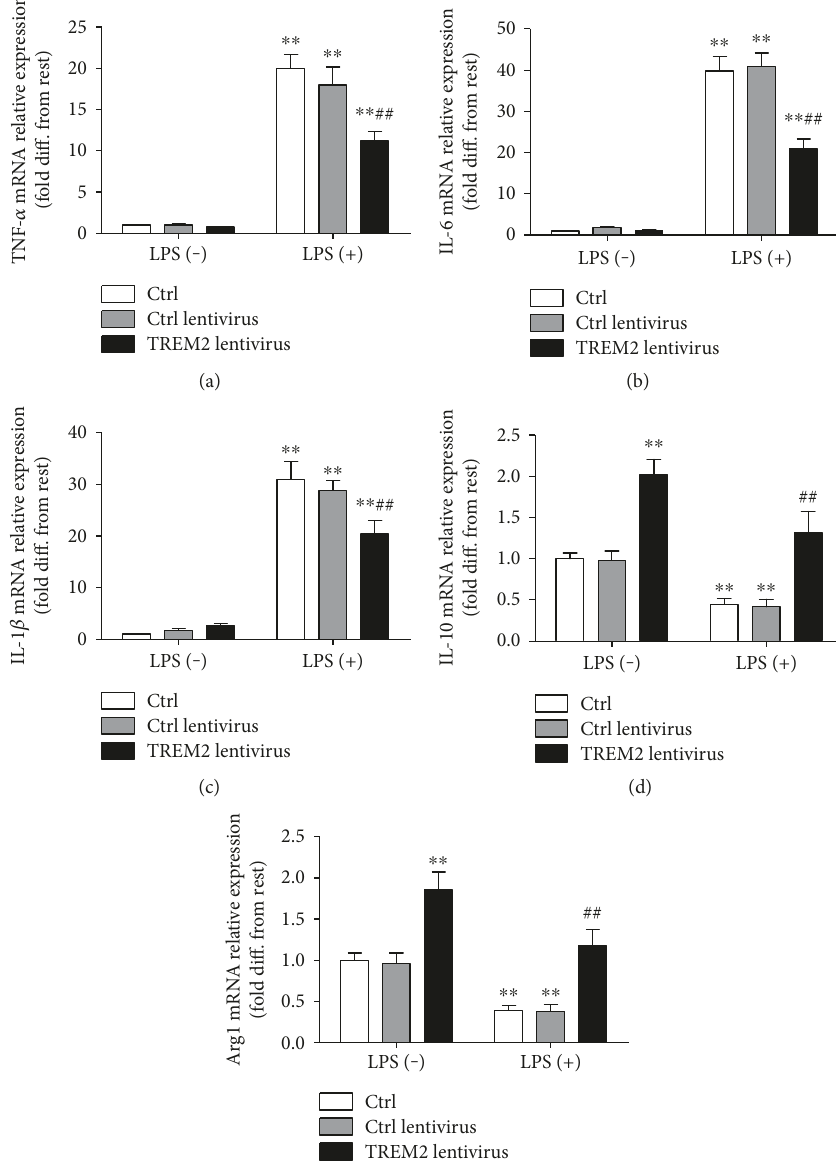
Figure 3: Overexpression of TREM2 in primary microglia attenuated LPS-induced elevation of TNF- α , IL-6, and IL-1 β (a, b, c) and increased IL-10 and Arg1 level with/without LPS (d, e). Microglia were treated with TREM2 lentivirus before LPS stimulation. The level of M1 and M2 phenotype of microglia was detected by RT-PCR ( ∗∗ P < 0 01 versus control group, ## P < 0 01 versus LPS treatment